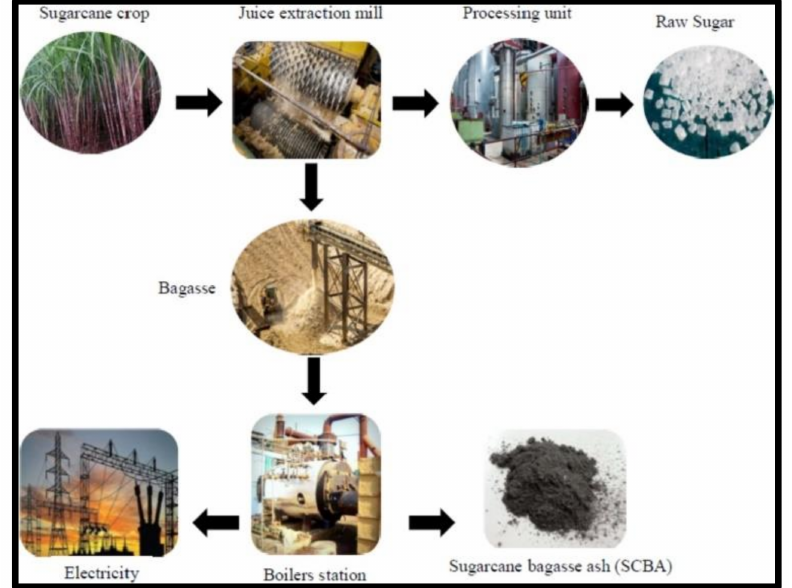
Figure 1. Flow diagram of sugarcane bagasse ash